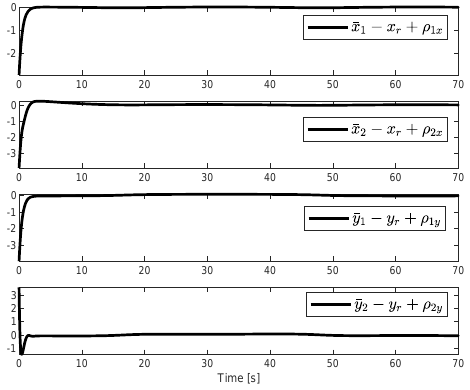
Figure 8. The tracking errors in the X and Y directions corresponding to the two followers without considering obstacle